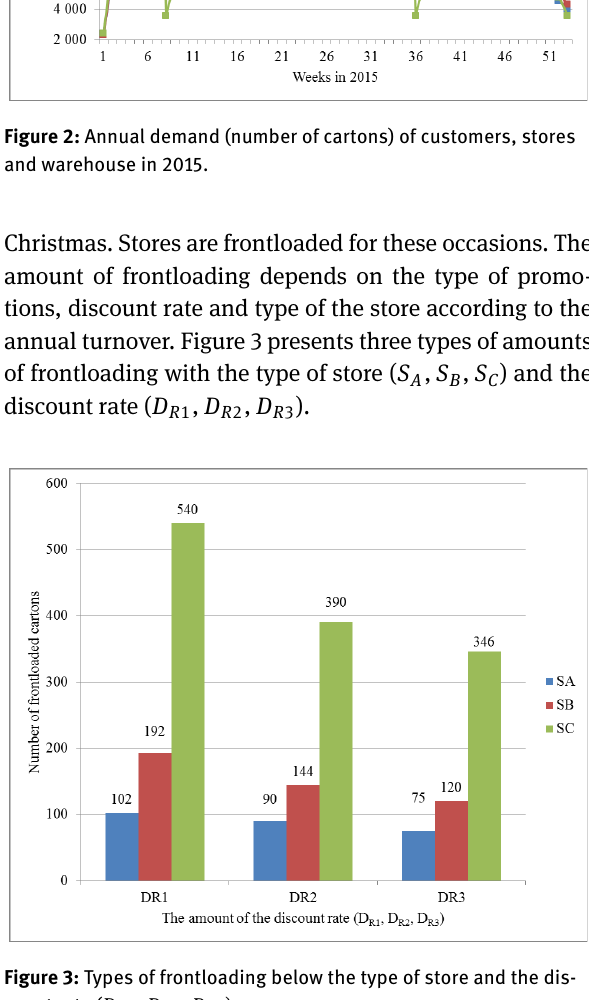
Table 2: The overview of the annual demand and its standard devia- tion.